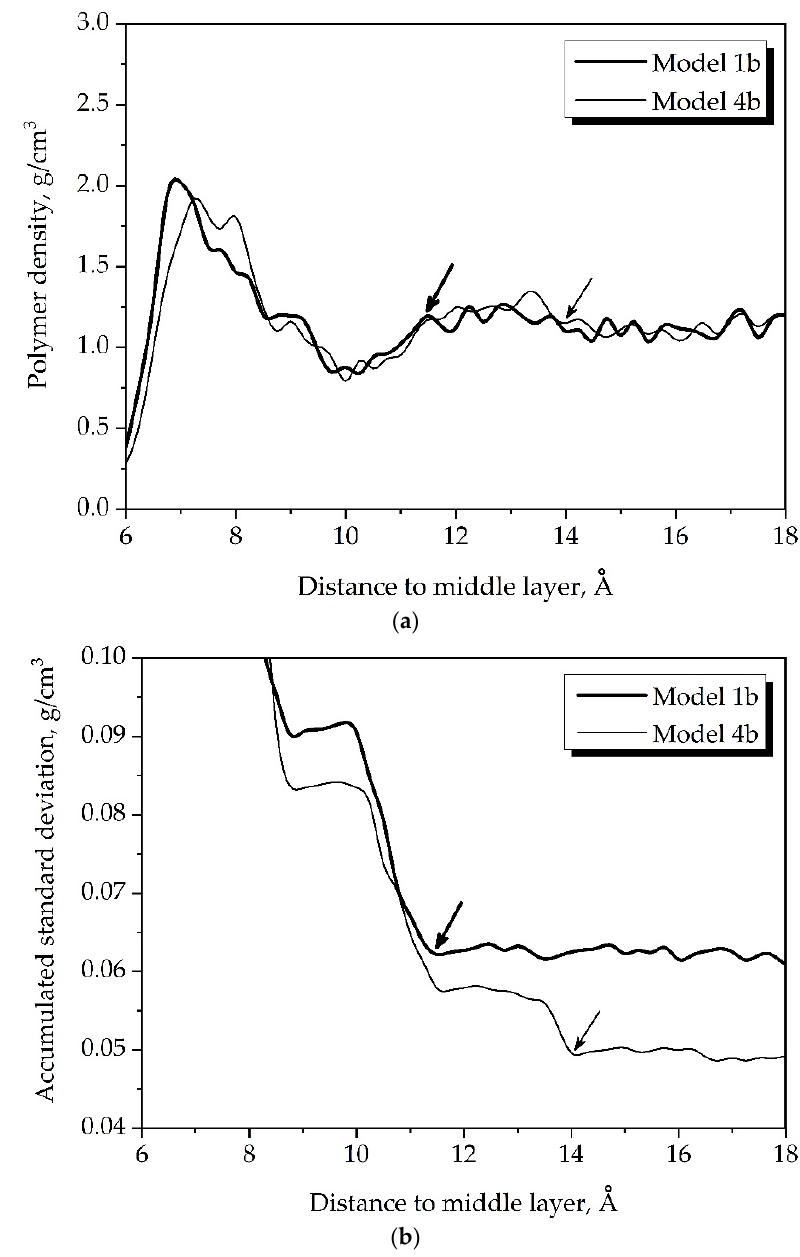
Figure 8. Comparison of ( a ) polymer density profiles and ( b ) accumulated standard deviation (ASD) curves between Model 1b (20.3 Å diameter) and Model 4b (CF or “infinite diameter”). The interface limit is indicated by arrows.